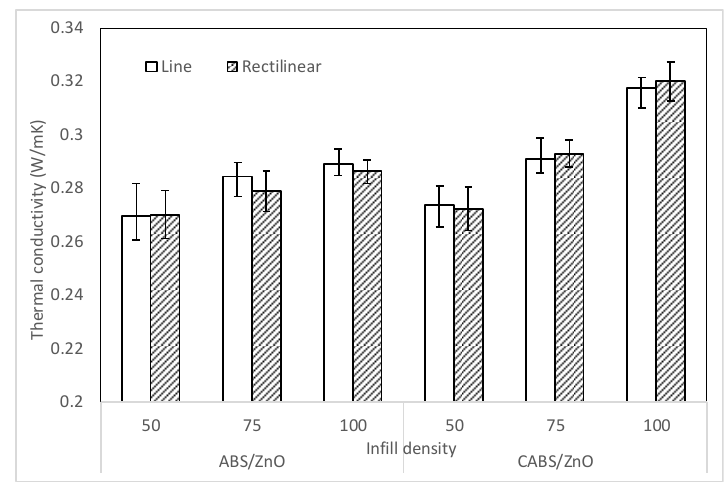
Figure 11. Thermal conductivity of ABS and CABS composites with different infill density and printing pattern.